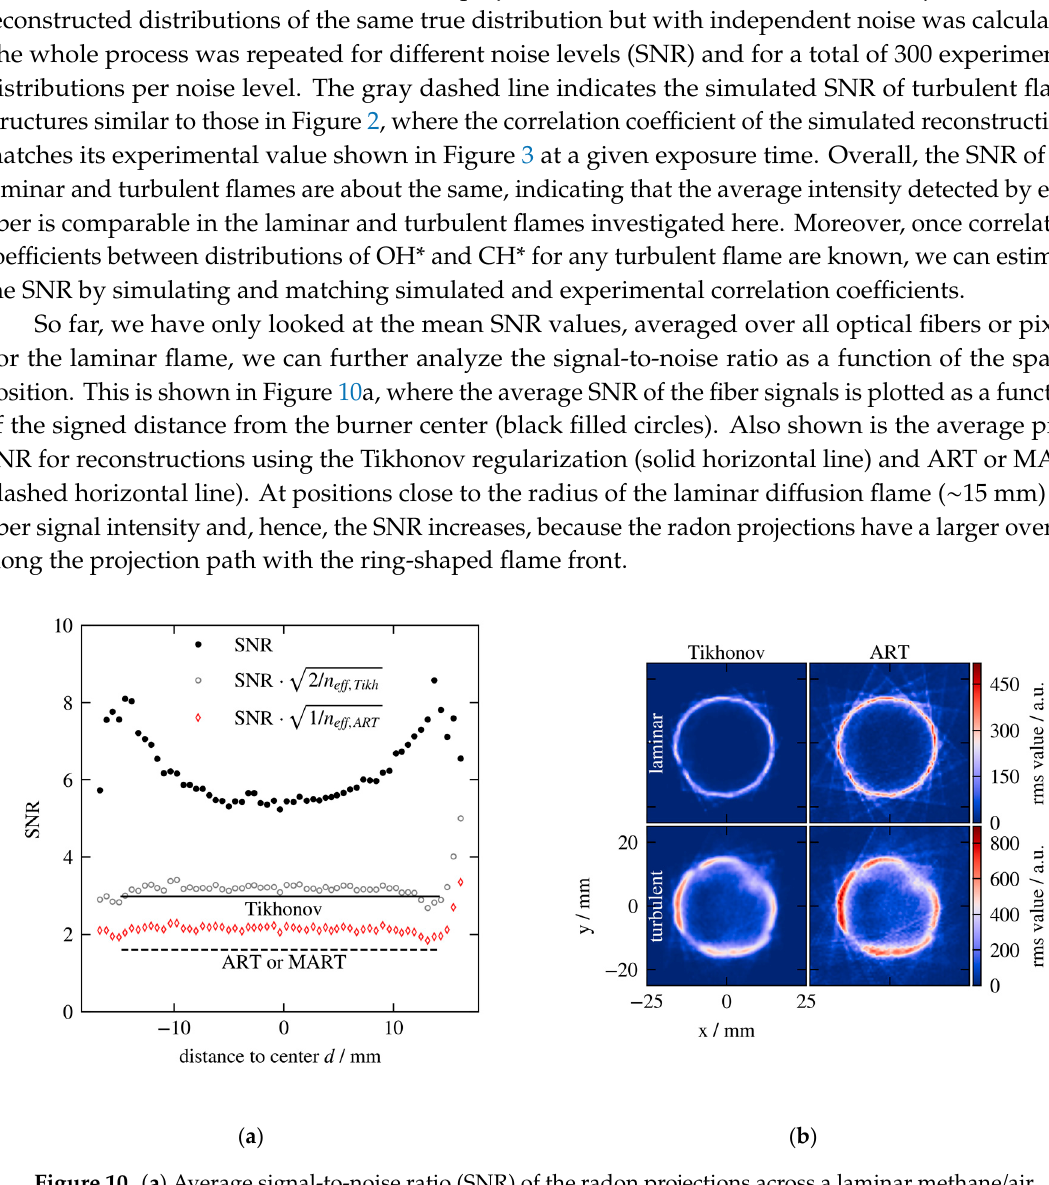
Figure 10. ( a ) Average signal-to-noise ratio (SNR) of the radon projections across a laminar methane/air diffusion flame at an exposure time of 1 ms (filled black circles). Also shown is the SNR normalized by the effective number of sampled pixels for Tikhonov regularization (open gray circles) and ART (open red diamonds) in comparison to the average pixel SNR of the reconstructed images (Tikhonov: solid line, ART: dashed line). ( b ) Root-mean-square (rms) values of the reconstructed intensities of a laminar (top row) or turbulent (bottom row) flame and for Tikhonov regularization (left column) and ART (right column).